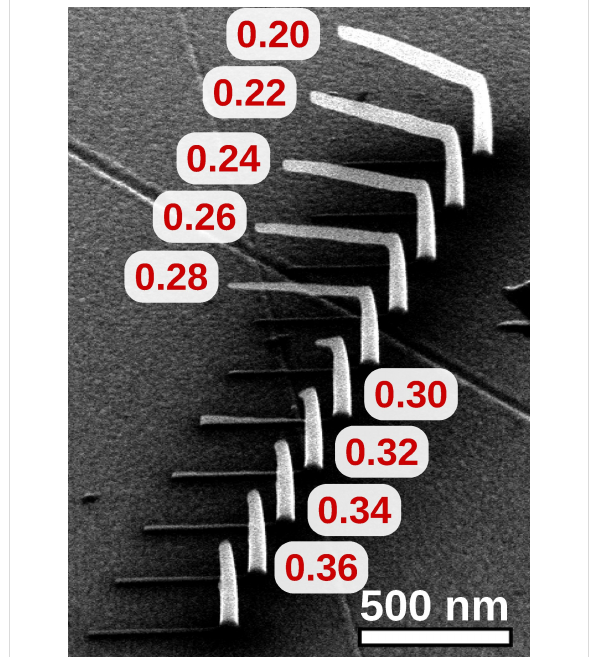
Figure 6: Calibration of deposition speed parameters x F und z F . Shown is one deposition series from 52° tilted view, made up of several elements where each consists of a vertical pillar and an edge which is defined with a horizontal inclination in the geof. For every hori- zontal edge an individual x F was used by a special command in the geof. The x F values are displayed next to each element and range in this example from 0.20 to 0.36 nm per frame. This deposit was written in normal mode with 20 kV, approx. 40 pA using the precursor Me 3 CpMePt(IV). In this example the best value for x F is between 0.28 and 0.30. In order to calibrate z F the measured height of the vertical pillars has to be evaluated, see Equation 3. Here z F was 0.135 nm per